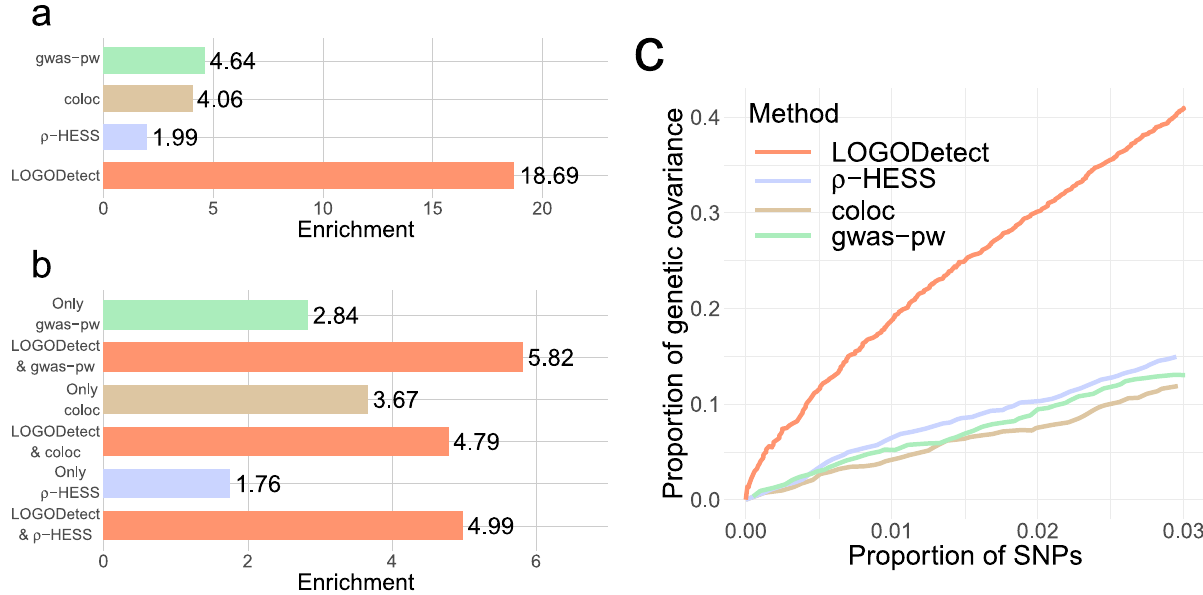
Fig. 4 LOGODetect identi fi es precise genomic regions harboring local genetic correlations. Genetic covariance and its corresponding enrichment were calculated using strati fi ed-LDSC 10 . a Genetic covariance fold enrichment (i.e. the ratio between the proportion of total genetic covariance and the proportion of the total SNP counts) in regions identi fi ed by LOGODetect, ρ -HESS, coloc, and gwas-pw, respectively. b Genetic covariance fold enrichment in regions identi fi ed by ρ -HESS, coloc, and gwas-pw that also overlapped with LOGODetect fi ndings, and regions identi fi ed by ρ -HESS, coloc, and gwas-pw alone. c Genetic covariance explained and proportion of SNPs covered by regions identi fi ed by LOGODetect, ρ -HESS, coloc, and